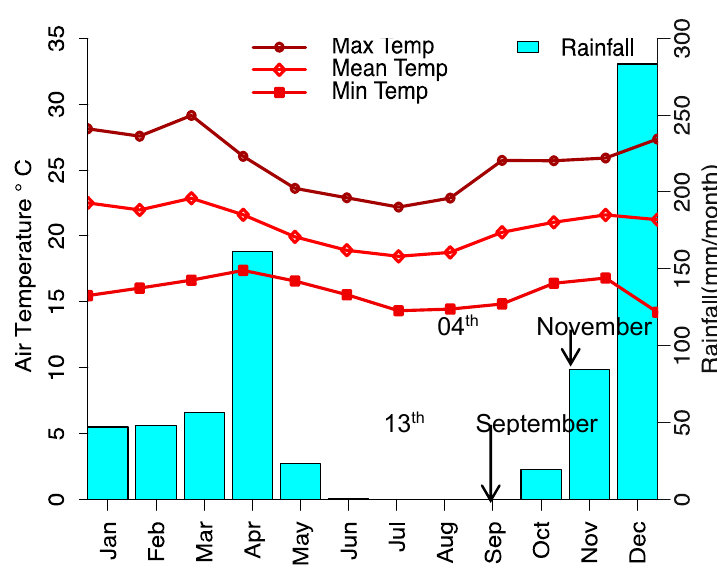
Figure 2. Annual average monthly rainfall and temperature variation in Duru-Haitemba and Bereko forest reserve for 2009 (Source: Arusha Meteorological Station).